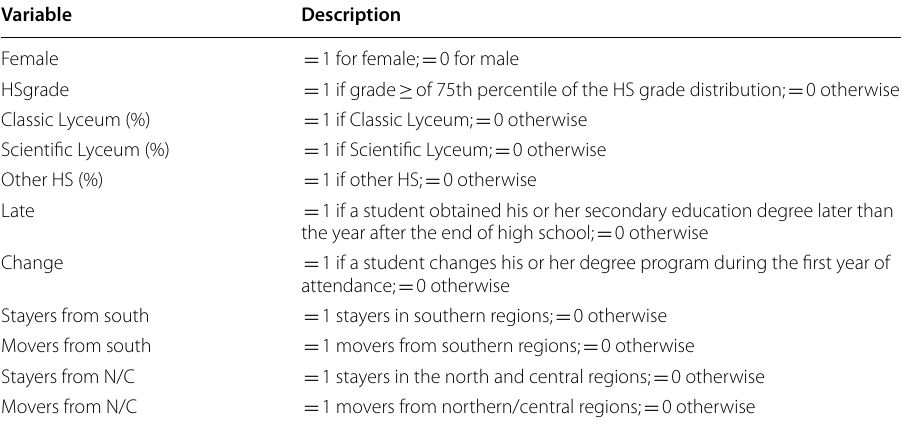
Table 1 Description of